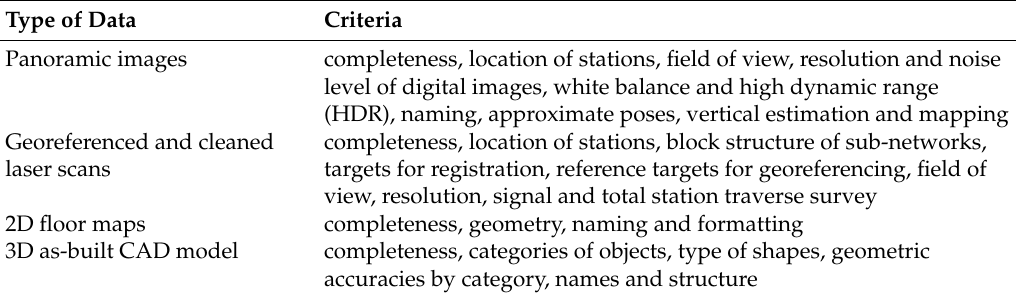
Table 1. Criteria of a multi-sensor survey of a building with complex